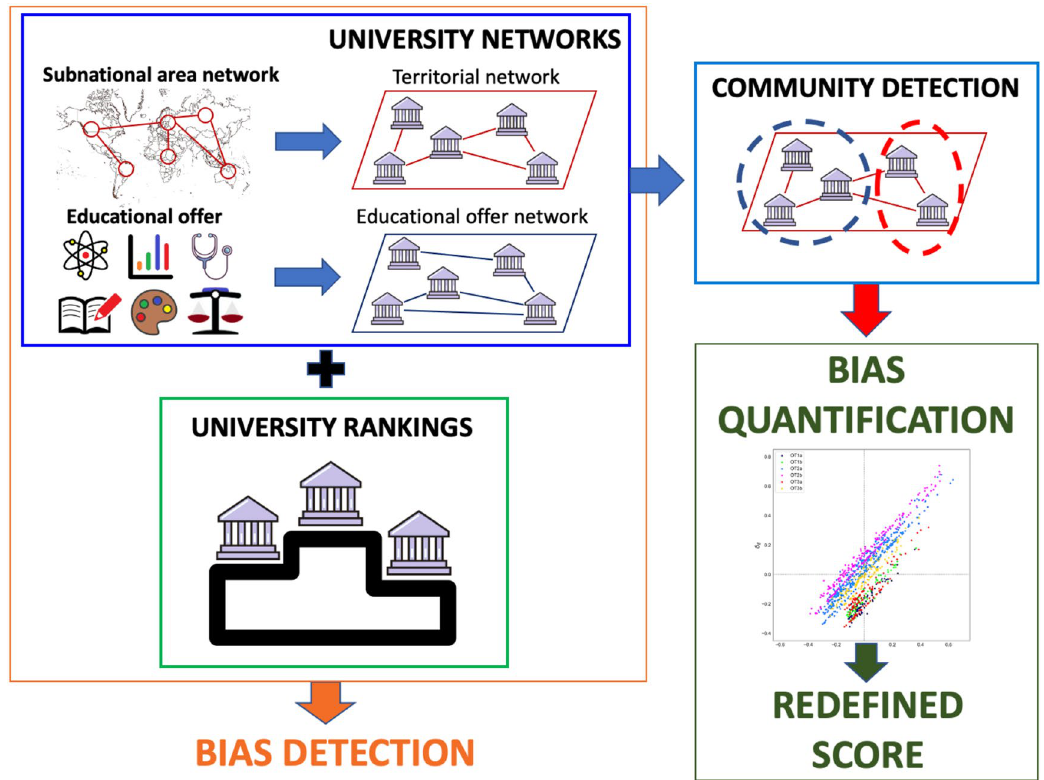
Figure 1. Scheme representing the workflow of the analysis. Indicators on the territorial features (used to construct a network of subnational areas) and information on the educational offer of academic institutions constitute the basis to build a territorial network and an educational offer network of universities, respectively. Network analysis enables to detect and quantify biases in university rankings, providing the necessary information to define a new score in view of a fair